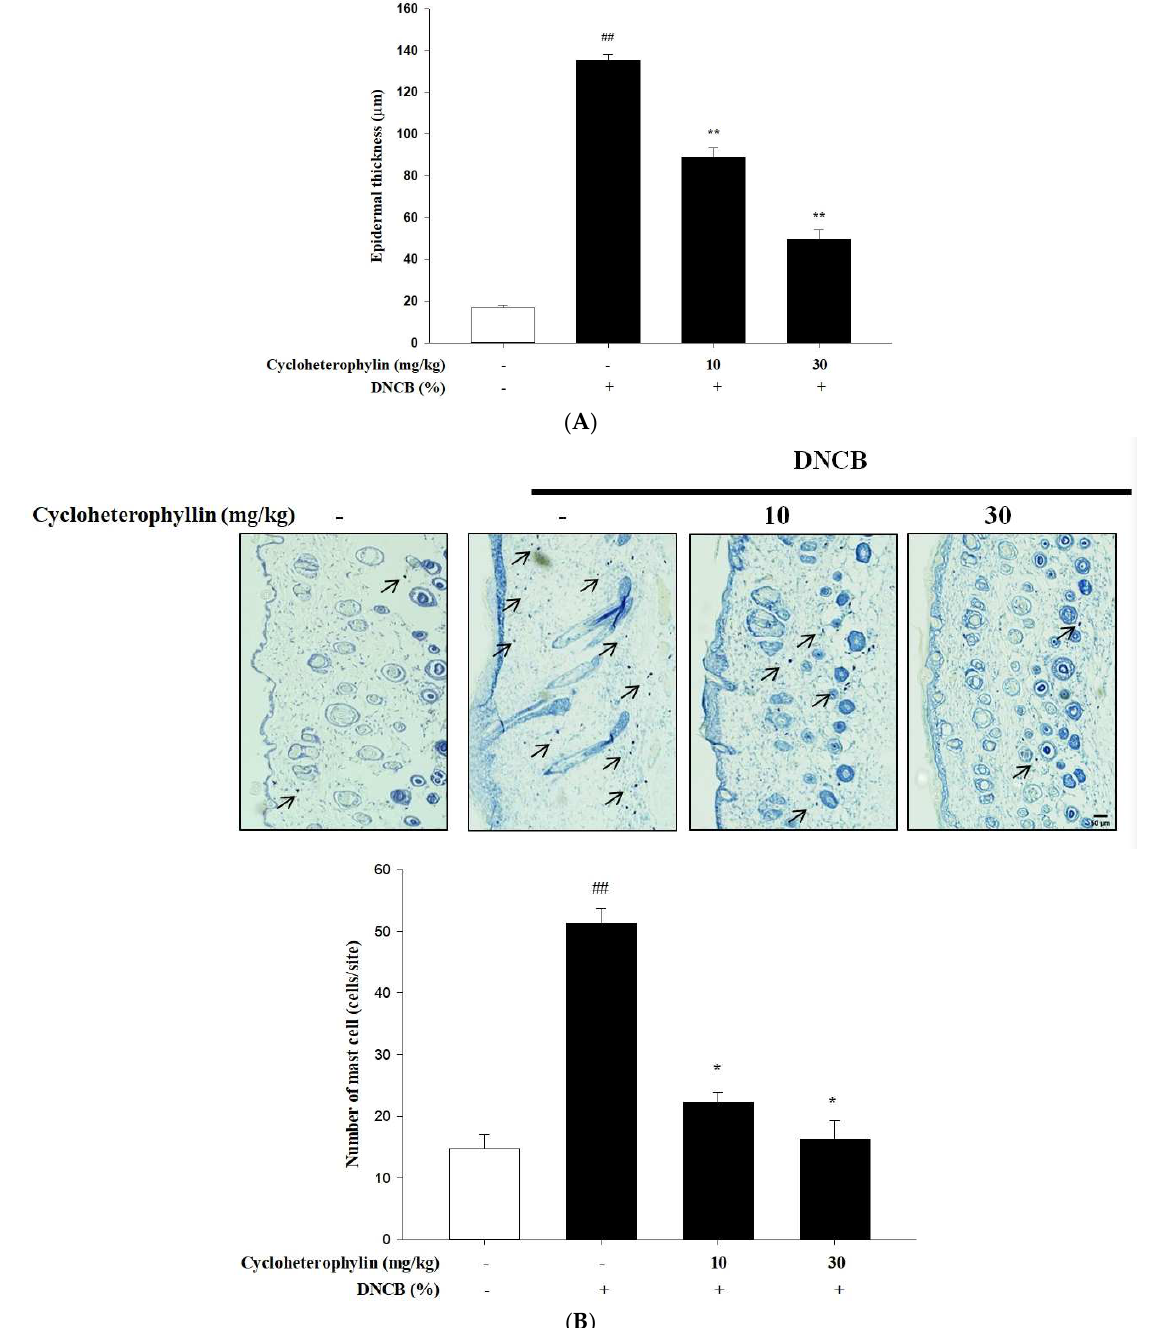
Figure 8. Effects of cycloheterophyllin on epidermal hyperplasia and mast cell infiltration. ( A ) Upper panel: histopathological variation due to DNCB induction was evaluated using hematoxylin–eosin staining (scale bar, 50 μm). Lower panel: quantitative analysis of epidermal thickness. ( B ) Toluidine blue staining; scale bar: 20 μm. Arrows indicate mast cells. Lower panel: number of mast cells. Values represent the mean ± SEM from at least three independent experiments. ## p < 0.01 compared with the no-treatment condition; * p < 0.05 and ** p < 0.01 compared with the DNCB- induced group.